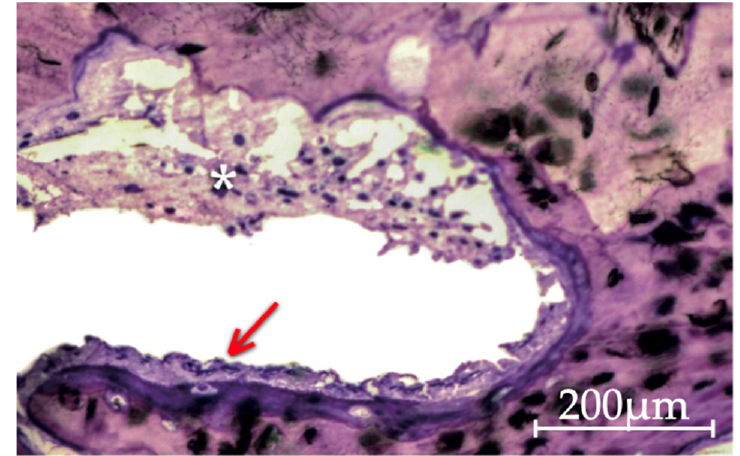
Figure 3. Histological image of the Gen-Os group at 30 days of evolution, showing a bone particle resorption process, with the creation of Howship’s lacunae by osteoclasts (asterisk), side by side with immature bone tissue formation processes by apposition to the particles, still with the presence of osteoblasts and osteoid (arrow) (200 × original magnification).